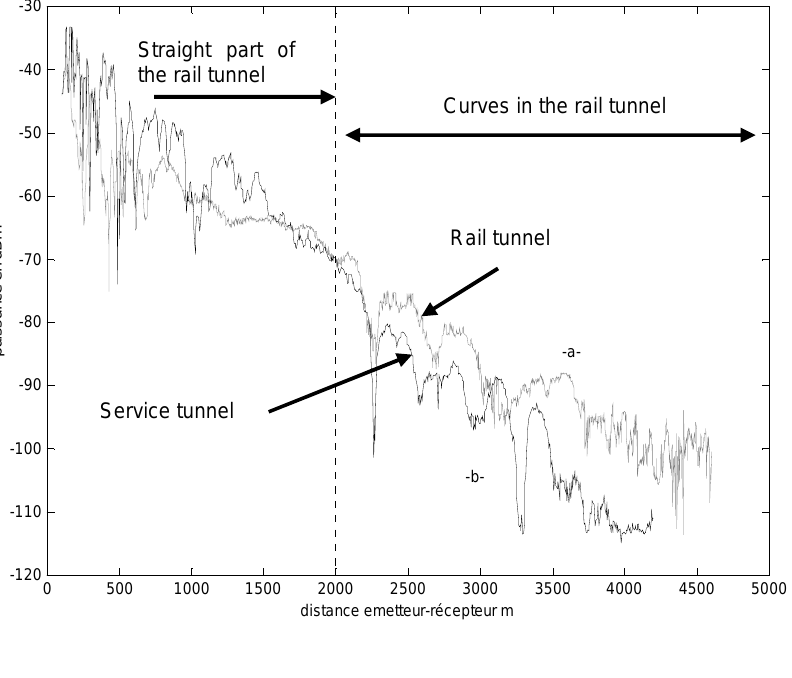
Figure 2. Received power versus distance at 2.45 GHz. (a) In the railway tunnel, (b) in the service